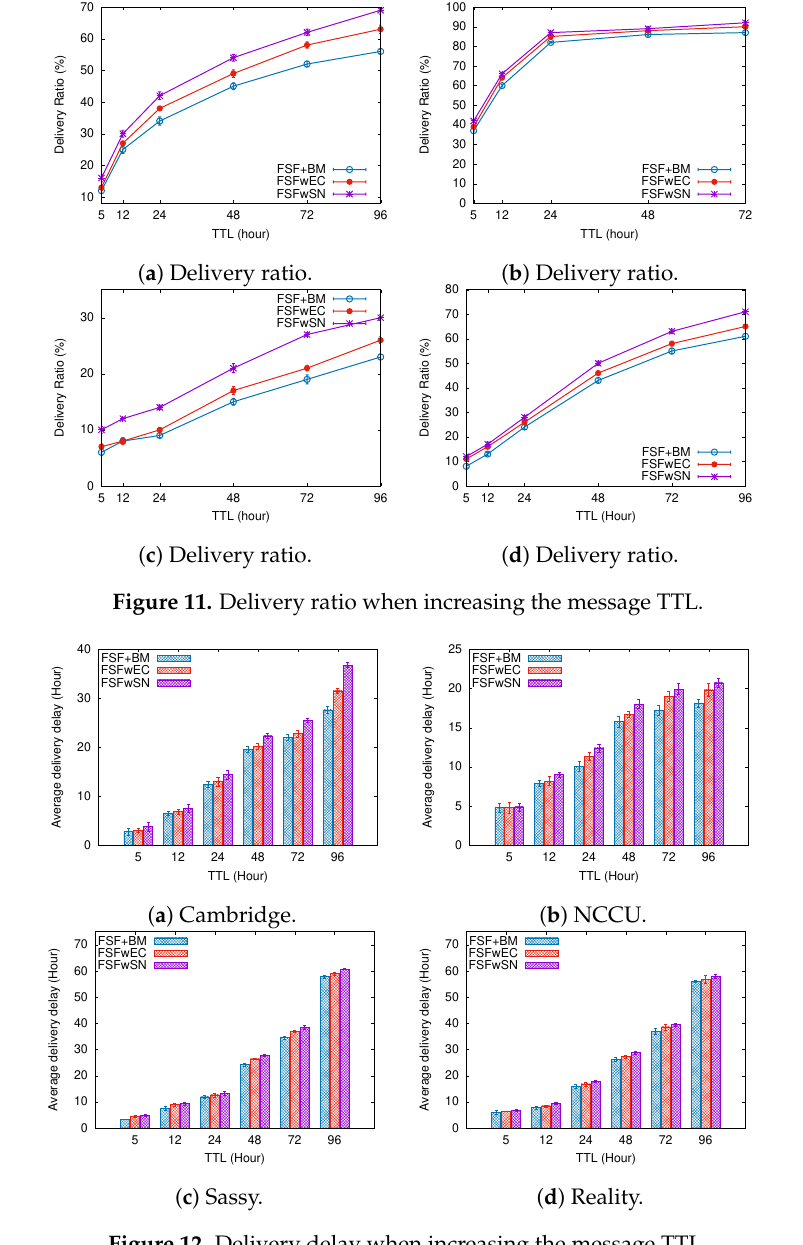
Figure 12. Delivery delay when increasing the message